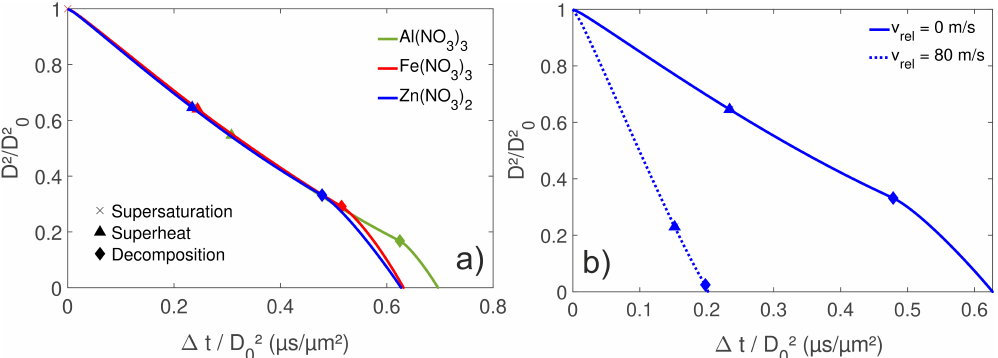
Figure 6. ( a ) Size evolution of solution droplets including onset of liquid-phase precipitation, superheat and precursor decomposition; ( b ) influence of droplet relative velocity on the size